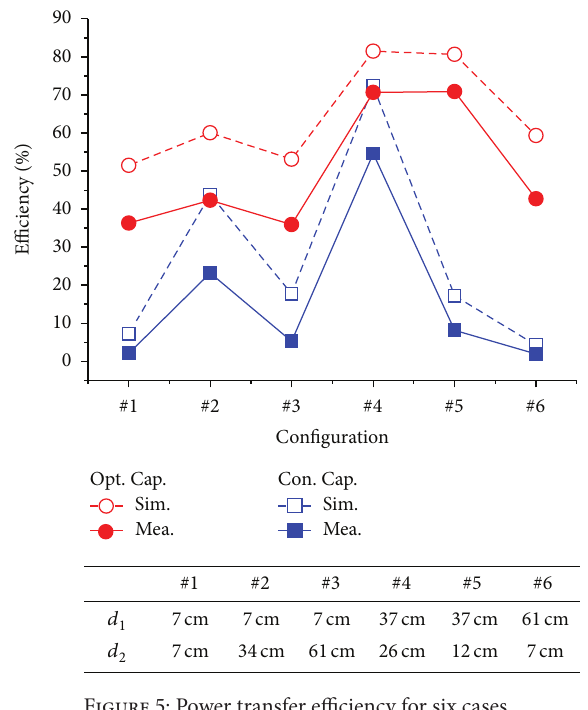
Figure 5: Power transfer efficiency for six cases.